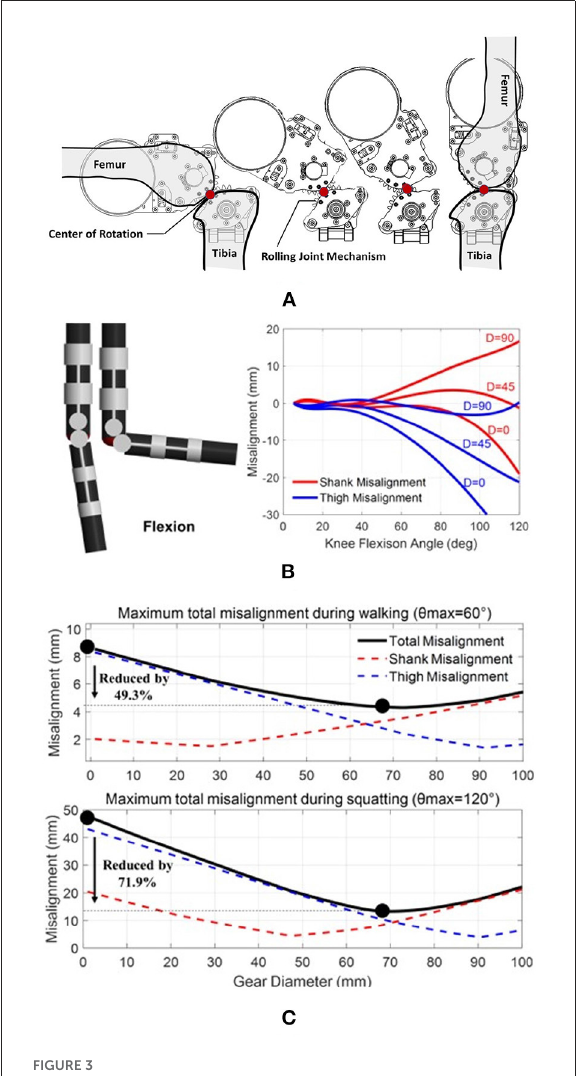
FIGURE3 (A) The bioinspired rolling-gear based knee joint mechanism can provide equivalent rolling and sliding motion during knee joint movement. Compared with traditional fi x -axis rotation robot joint designs, the design can mitigate joint misalignment. The non-fixed rotation center is defined by the contact point between the two gears; (B) Simulation of the misalignment effect for the rolling joint design. The red and the blue lines represent the misalignment functions at the shank and the thigh during the knee flexion motion, respectively; (C) Joint misalignment reduction simulation results during walking ( θ max = 60 ◦ ) and deep squatting ( θ max = 120 ◦ ).